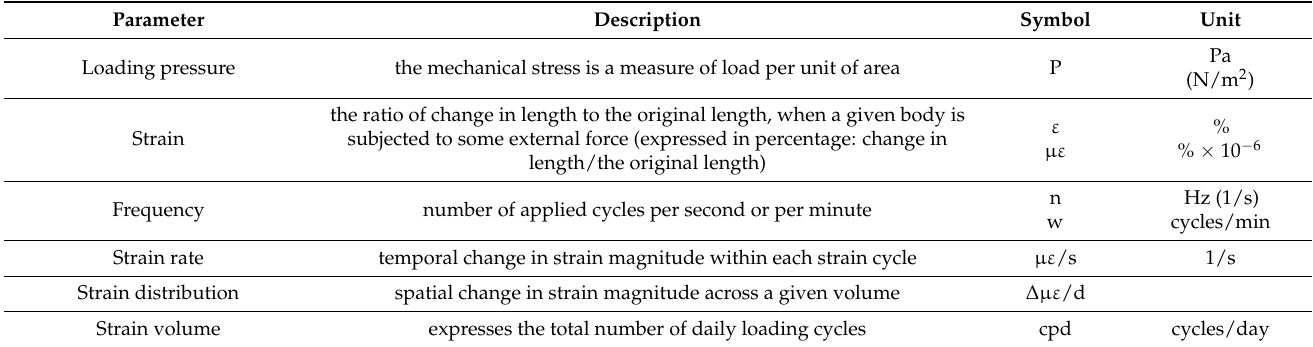
Table 3. Mechanical parameters employed for the description of physical stresses in mechanobiology.